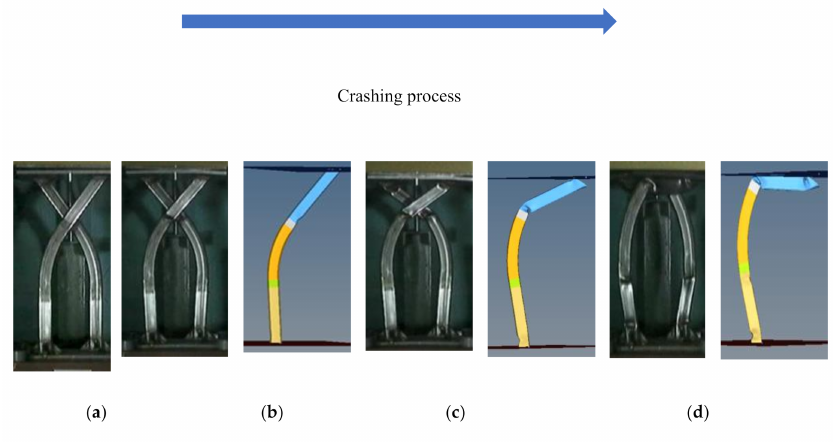
Figure 13. Comparison of crash deformation of partially quenched product between experiment and simulation in axial crash test: ( a ) initial product shape, ( b ) axial stroke = 15 mm, ( c ) axial stroke = 85 mm, and ( d ) axial stroke = 177